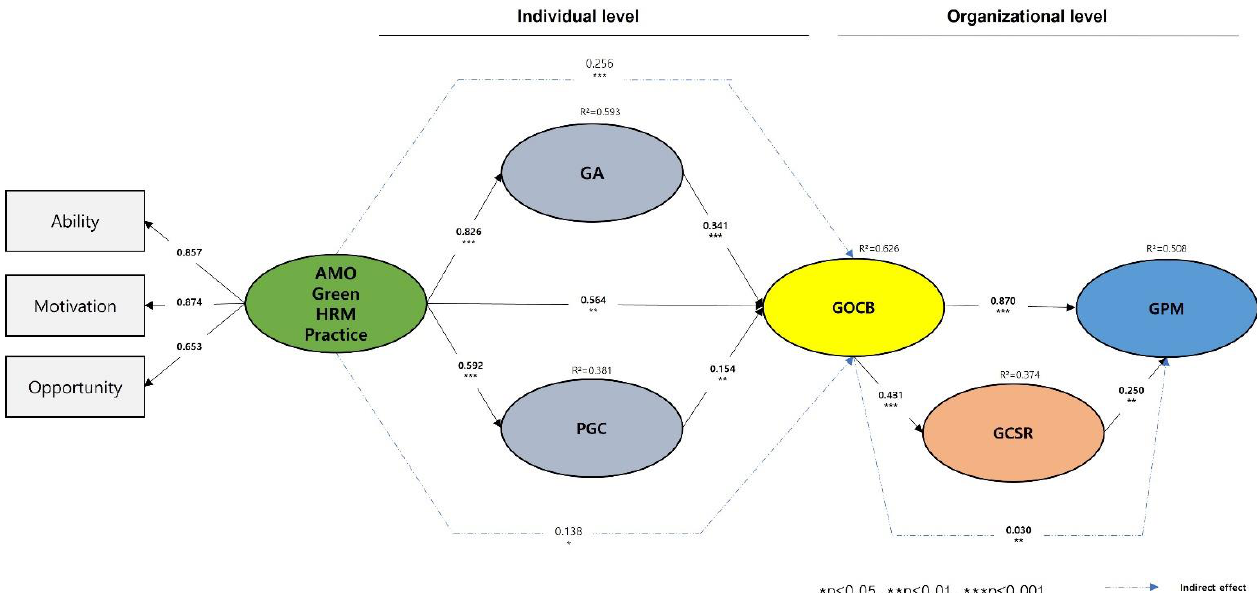
Figure 1. Structural equation model estimation and test for structural metric invariance. Note 1. Green HRM practice (GHRM), green awareness (GA), green psychological climate (GPC), green organizational citizenship behavior (GOCB), green performance management (GPM), green CSR perception (GCSR). Note 2. Goodness-of- fit statistics for the measurement model: χ 2 = 802.227, df = 694, p < 0.001, χ 2 /df = 0.865, RMSEA = 0.022, CFI = 0.985, IFI = 0.985, TLI = 0.982, * p < 0.05, ** p < 0.01, *** p < 0.001. Note 3. Goodness-of- fit statistics for the measurement model: χ 2 = 794.213, df = 691, p < 0.001, χ 2 /df = 0.870, RMSEA = 0.022, CFI = 0.986, IFI = 0.986, TLI = 0.983, * p < 0.05, ** p < 0.01, *** p < 0.001; Note 4. All factors’ loadings are significant at p < 0.001.